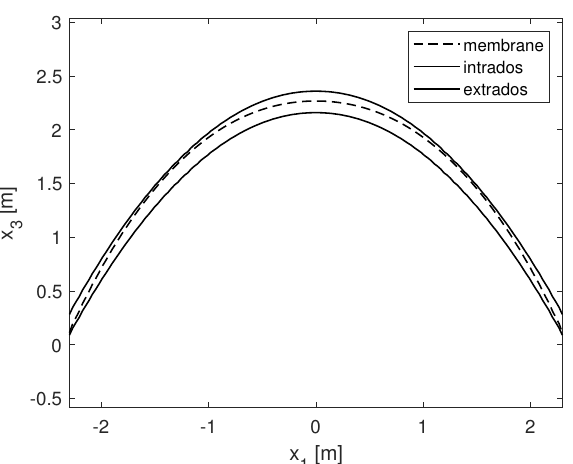
Figure 20. Section of the membrane and of the limit surfaces of the cross vault along the diagonal x 2 = − b i / a i x .